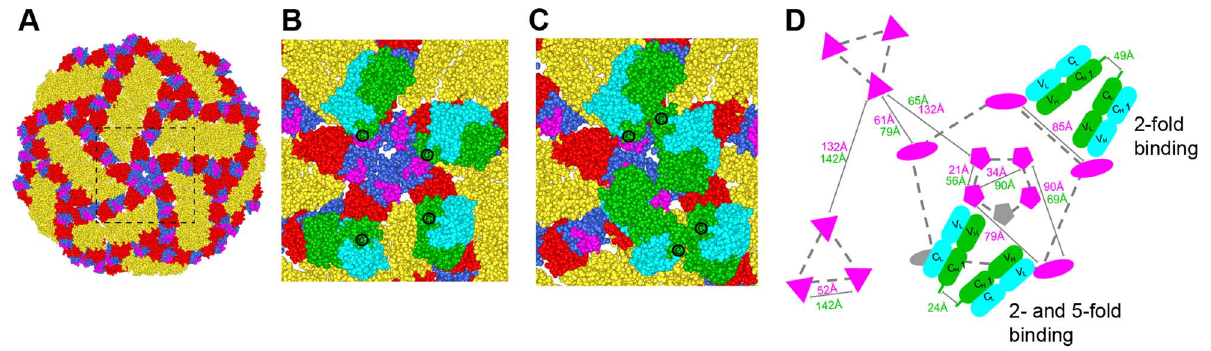
Figure 6. Modeling of E106 binding to DENV. ( A ) The E106 epitope is highlighted in magenta on a DENV-1 model of the DENV-2 cryo-electron microscopic reconstruction (PDB code 1P58). All atoms of the model are displayed and colored by domains (DI, red; DII, gold; DIII, blue). Magnified view of the boxed region in (A) with E106 Fab docked onto the epitopes at the primary candidates for bivalent antibody binding namely ( B ) adjacent 2-fold epitopes (49 A˚ CH1 separation) which is permuted as an outer 5-fold ring and ( C ) adjacent inner and outer 5-fold epitopes (24 A˚ CH1 separation). E106 Fab heavy and light chain is represented by green and cyan spheres, respectively. The C-terminal CH1 residue is represented by ‘C’. ( D ) Schematic of the possible arrangements of E106 MAb bivalent binding to the lateral ridge plus A-strand epitope (magenta) on a single virion. The distances labeled in magenta and green are E106 epitope (T329) and C-terminal CH1 residue (R214) distances respectively. One Fab pair (green, heavy chain; cyan, light chain) is shown across the 5- and 2-fold and another involves adjacent 2-fold symmetry axes (the 2-fold permutes as an outer 5-fold ring, dashed gray line). 5-, 3- and 2-fold axes of symmetry are connected by gray dashed lines for clarity and represented by pentagons, triangles, and ovals, respectively. Epitopes that are occluded as a result of bivalent binding are shown in gray.